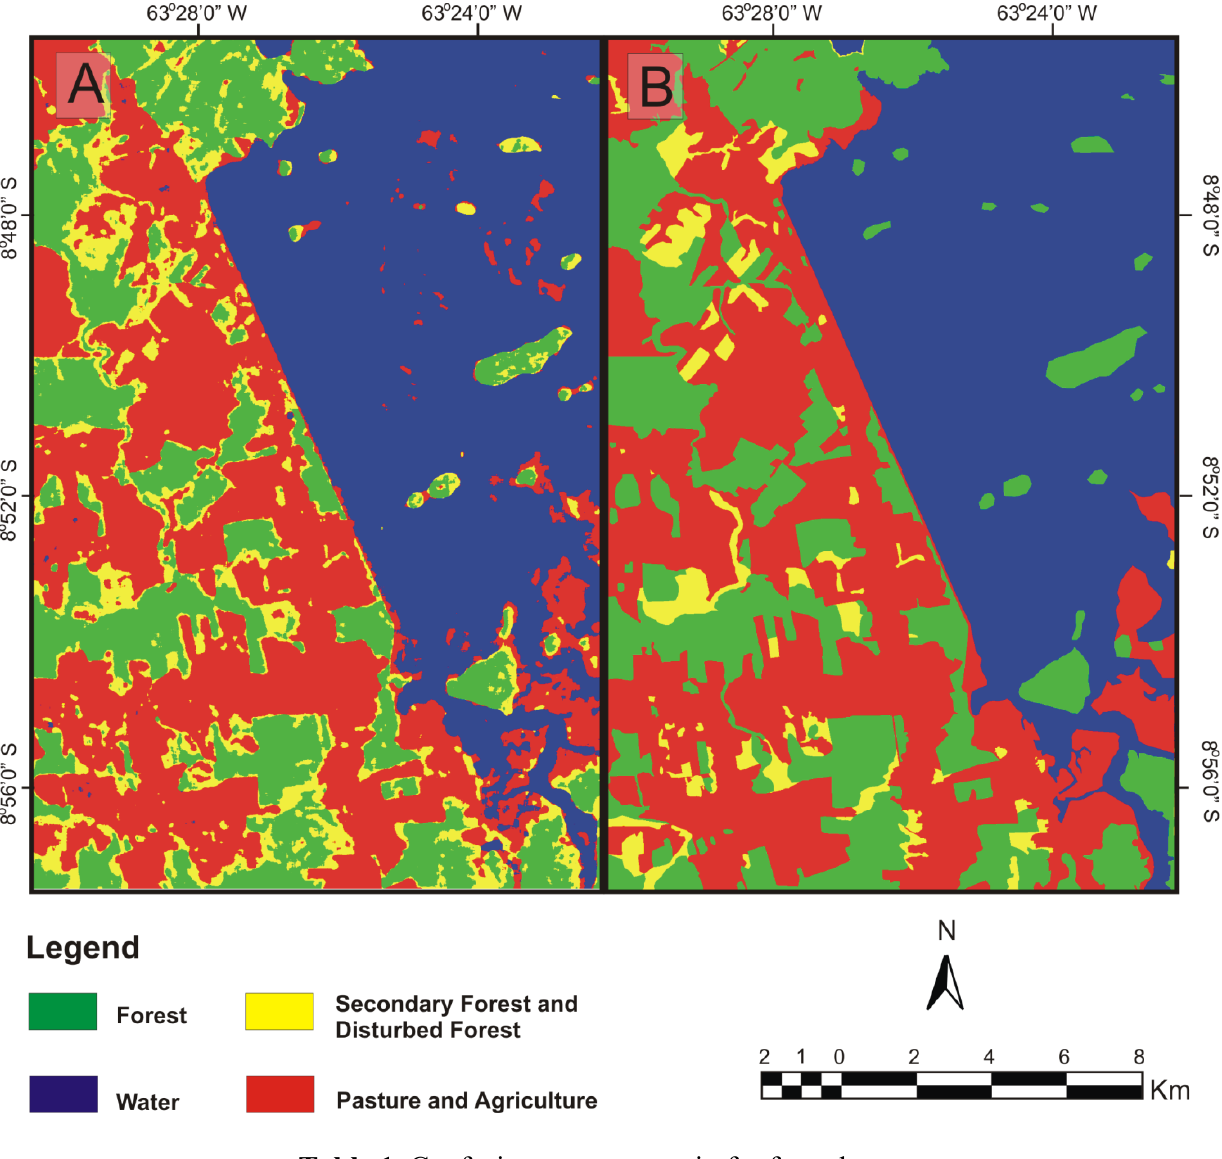
Table 1. Confusion or error matrix for four